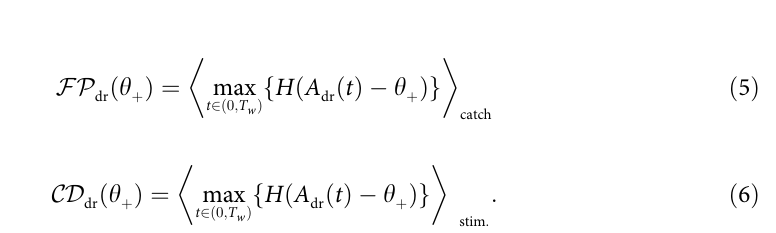
) is adjusted such that ei